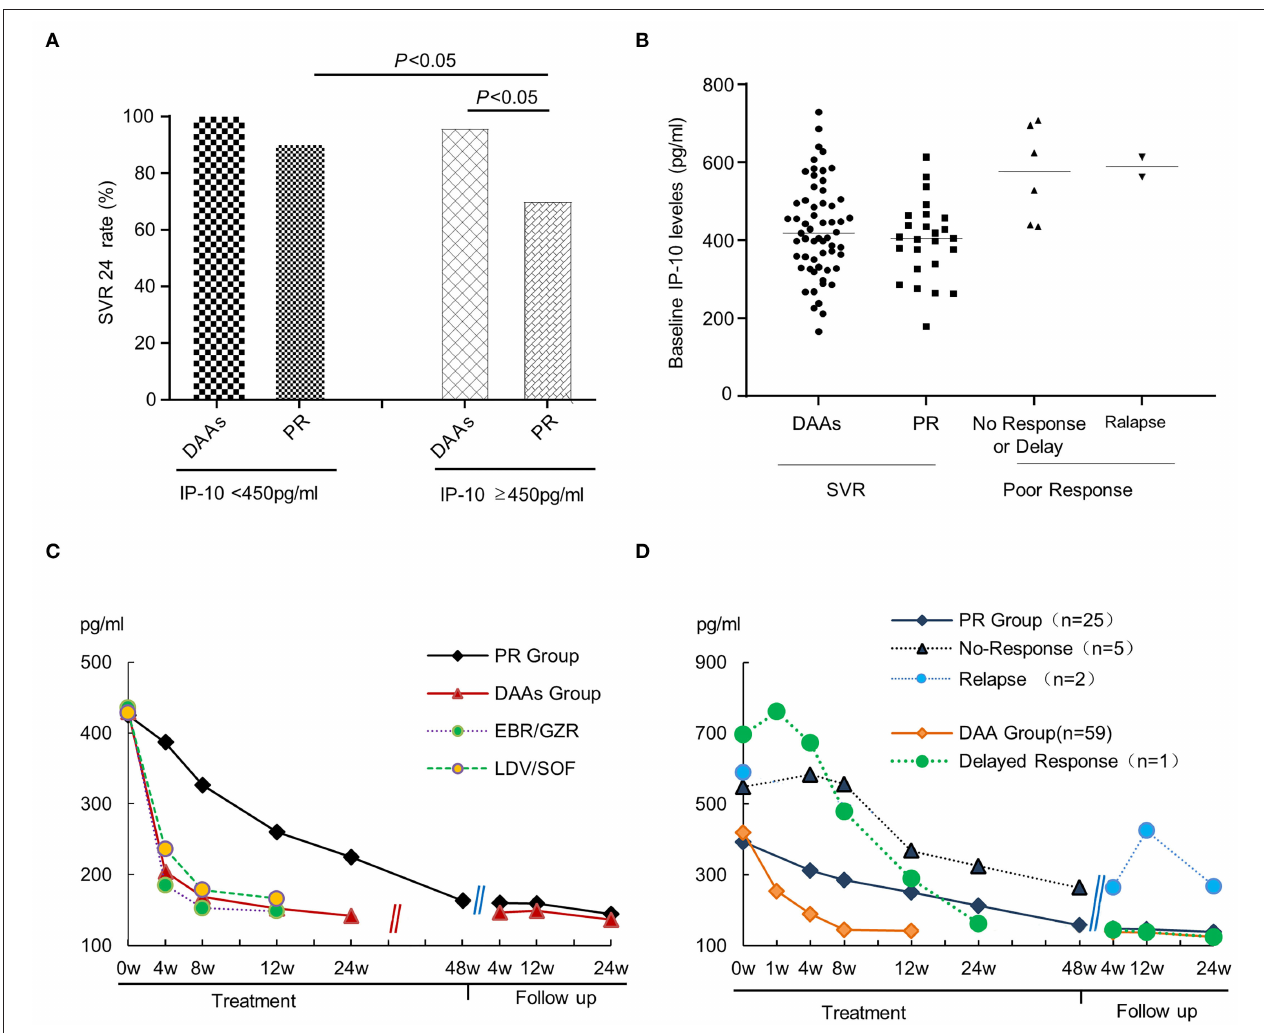
FIGURE 2 | The relationship between serum IP-10 levels and SVR rate in HCV-infected patients. (A) In the combined analysis, the SVR rate was statistically higher in IP-10 levels < 450ng/ml group than that in IP-10 levels ≥ 450ng/ml group, with the SVR rates being 96.43% and 88.24%, respectively ( p < 0.05). Based on another perspective, the SVR rate was statistically higher in the DAAs treatment group than that in the PR treatment group for patients with IP-10 levels ≥ 450ng/ml (95.83% vs. 70%). (B) A retrospective analysis showed the baseline IP-10 levels in patients with poor response (delayed/no-response), or relapse was slightly higher than in those patients who achieved SVR, although there was no statistical difference between the two subgroups due to the limited cases. (C) From the initiation of antiviral therapy, serum IP-10 levels in every group decreased gradually, but declined faster in the DAAs group than in the PR group; (D) Compared with the patients who achieved SVR, serum IP-10 levels decreased more slowly and slightly, or even rise again in patients with poor treatment response or relapse after